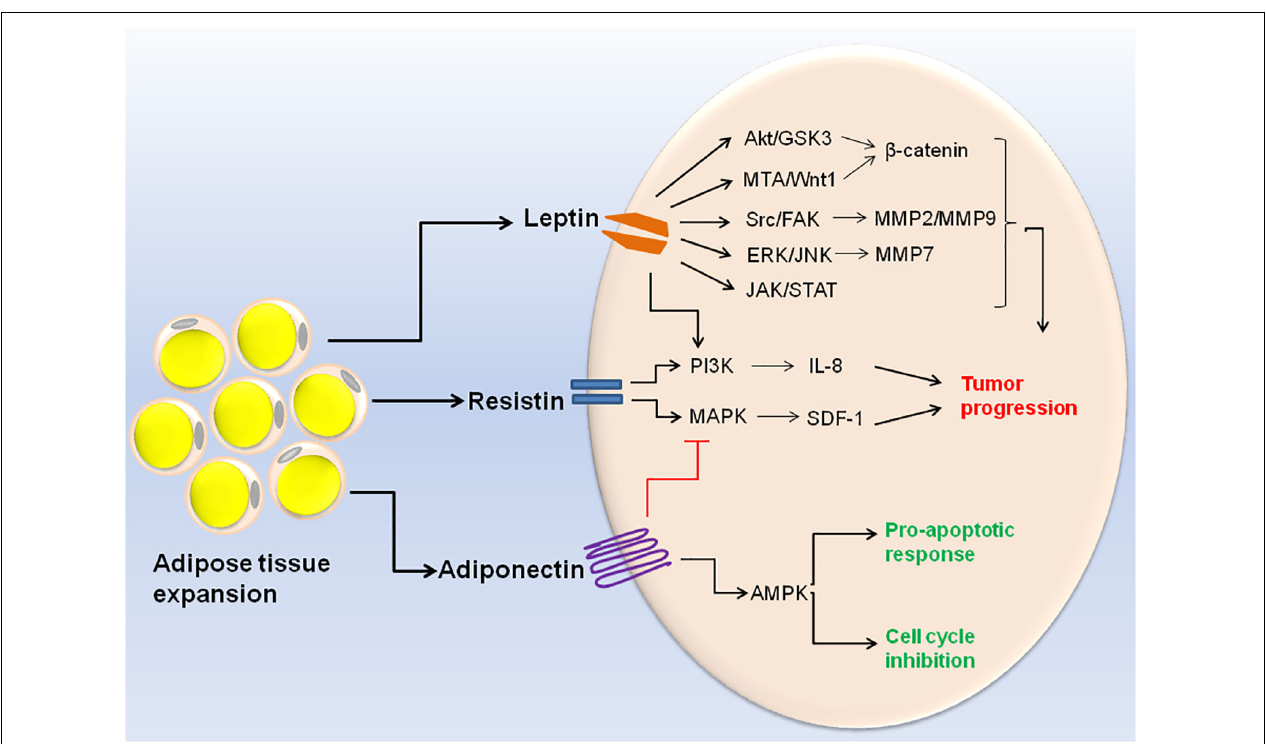
FIGURE 2 | Cell signaling events triggered by altered adipokine production during obesity. Expansion of adipose tissue in obese condition leads to altered adipokine production. High concentration of leptin and resistin results in the activation of different signaling pathways within the cell (Akt/GSK3, MTA/Wnt1, Src/FAK, ERK/JNK, JAK/STAT, PI3K, and MAPK). These signaling pathways ultimately lead to cancer cell invasion and metastasis. On the other hand, high adiponectin concentration leads to MAPK inhibition and AMPK inactivation which is responsible for its pro-apototic and anti-tumoral